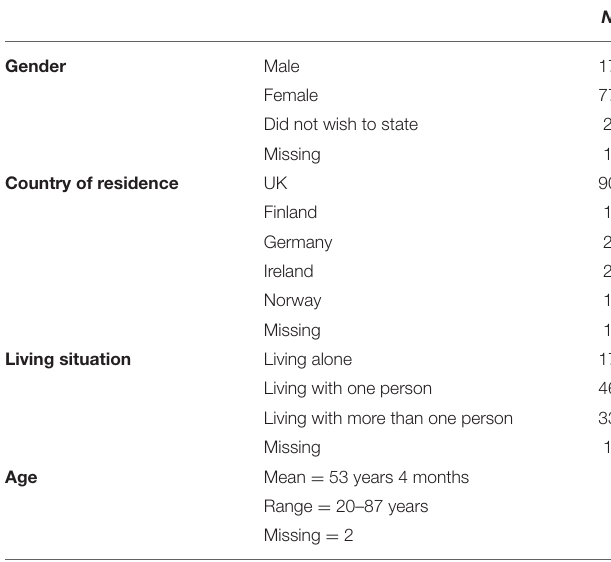
TABLE 1 | Demographics of online survey